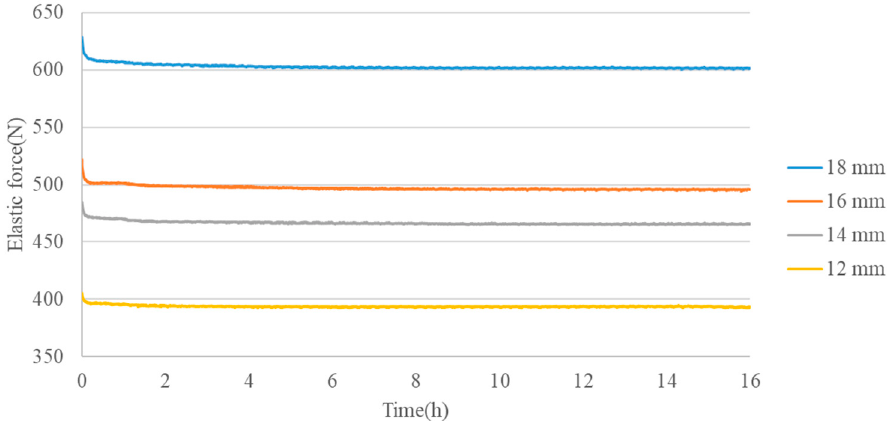
Figure 5. Elastic force relaxation curves under different compressions.